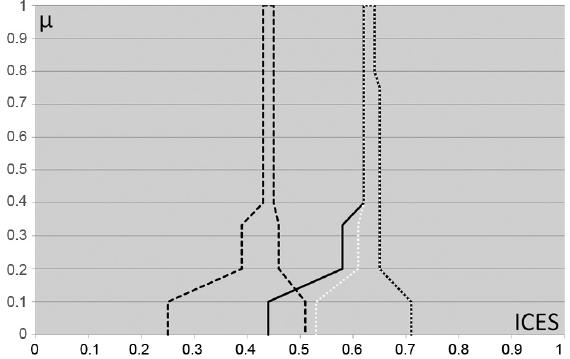
Fig. 4. Case study: fuzzy ICES for the three